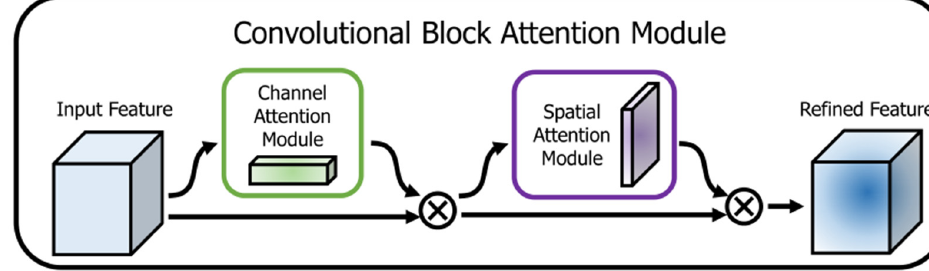
Figure 5. CBAM network structure.